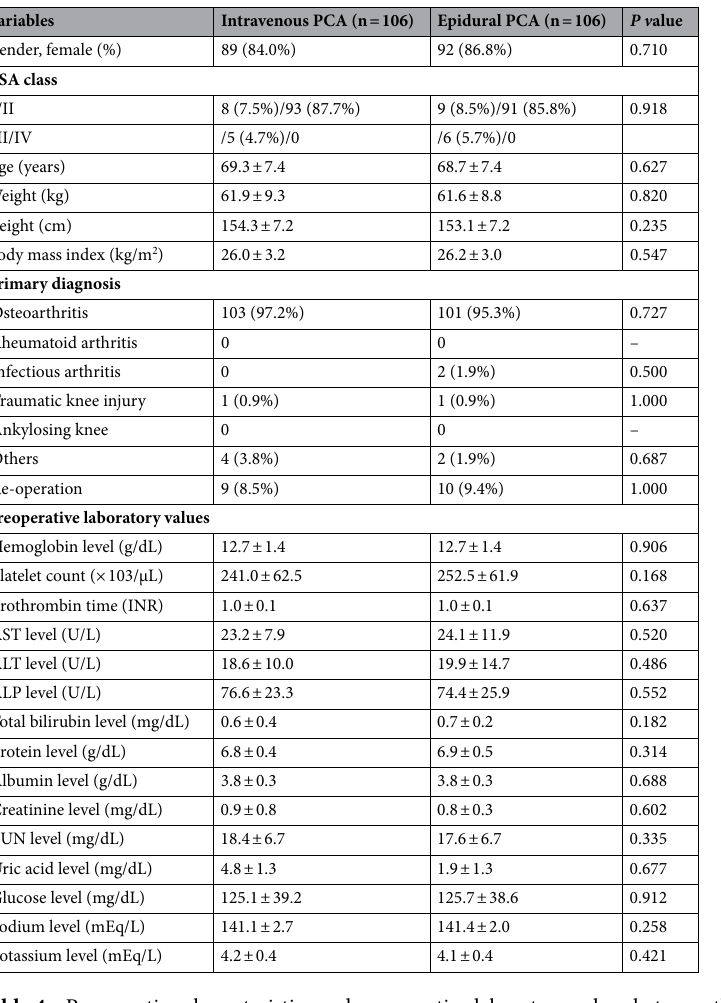
Table 4. Preoperative characteristics and preoperative laboratory values between the intravenous PCA and epidural PCA groups: PS-matched data. Data are presented as mean ± standard deviation or number (%), as appropriate. PCA patient-controlled analgesia, PS propensity score, ASA American Society of Anesthesiologists, INR international normalized ratio, AST aspartate transaminase, ALT alanine transaminase, ALP lkaline phosphatase, BUN blood urea nitrogen. Others include avascular necrosis, desmoplastic fibroma, fibrous dysplasia, pigmented villonodular synovitis, spontaneous osteonecrosis, valgus knee, spastic diplegia of cerebral palsy, and fused